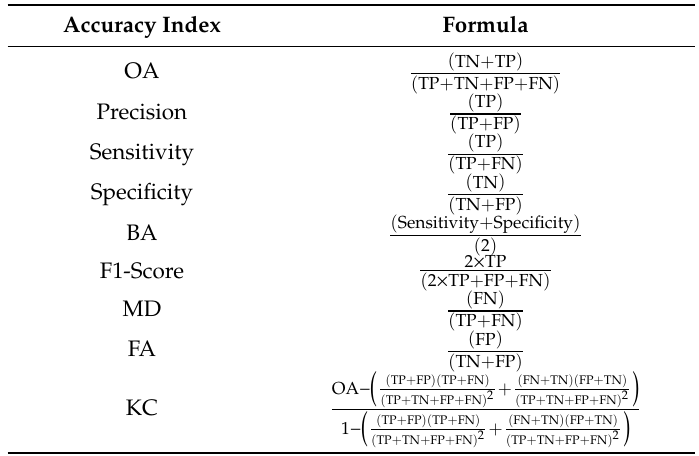
Table 5. Di ff erent types of indices that were used for accuracy assessment of the change map produced using the proposed method by components TP, TN, FP, and FN (TP: True Positive, TN: True Negative, FP: False Positive, and FN: False